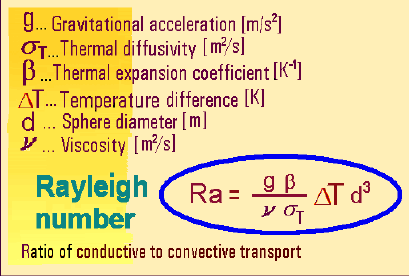
Fig. 8. The non-dimensionalised intensity of the vertical force acting on the liquid which generates the convective streaming is represented by the magnitude of Rayleigh number Ra